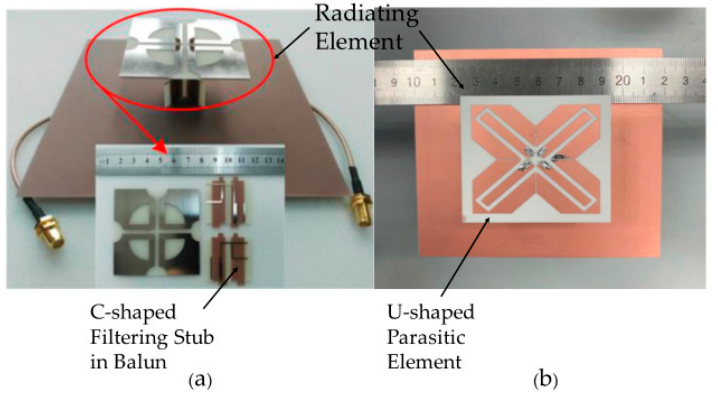
Figure 10. ( a ) Proposed antenna configuration [15]. ( b ) Parasitic element configuration in pro- posed antenna [20].